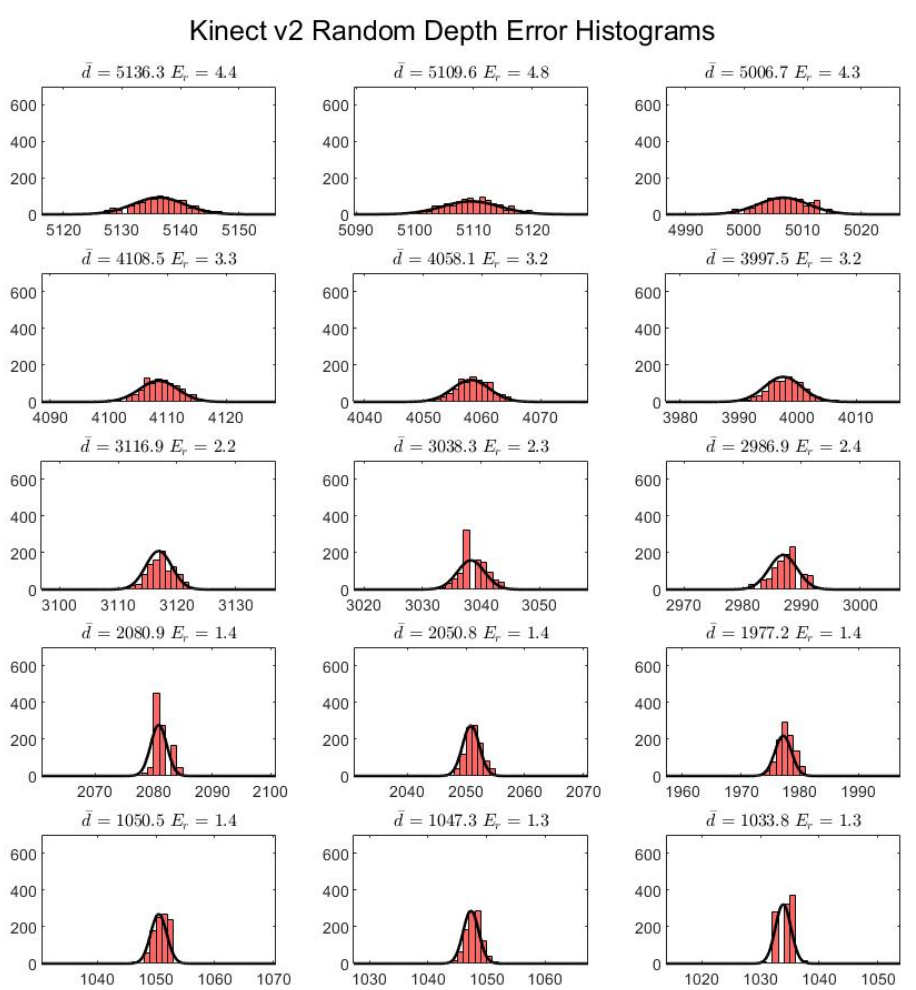
Figure 11. Random depth error for the Kinect v2, where d indicates the average depth value and E r is the standard deviation, or the random depth error. The horizontal axes and titles are in units of millimeters, while the vertical axes indicate bin counts. Each bin is 1 mm in width. The systematic spatial errors and their standard deviations are logged into Table 2. Using this data, a contour plot over the horizontal plane was generated from the key locations to visualize the error distribution across the range for both the Kinect v2 (Figure 13) and the Azure Kinect (Figure 14). To generate these plots, a mesh grid was created using Delaunay triangulation. The data were then linearly interpolated using MATLAB’s griddata function and displayed as a surface